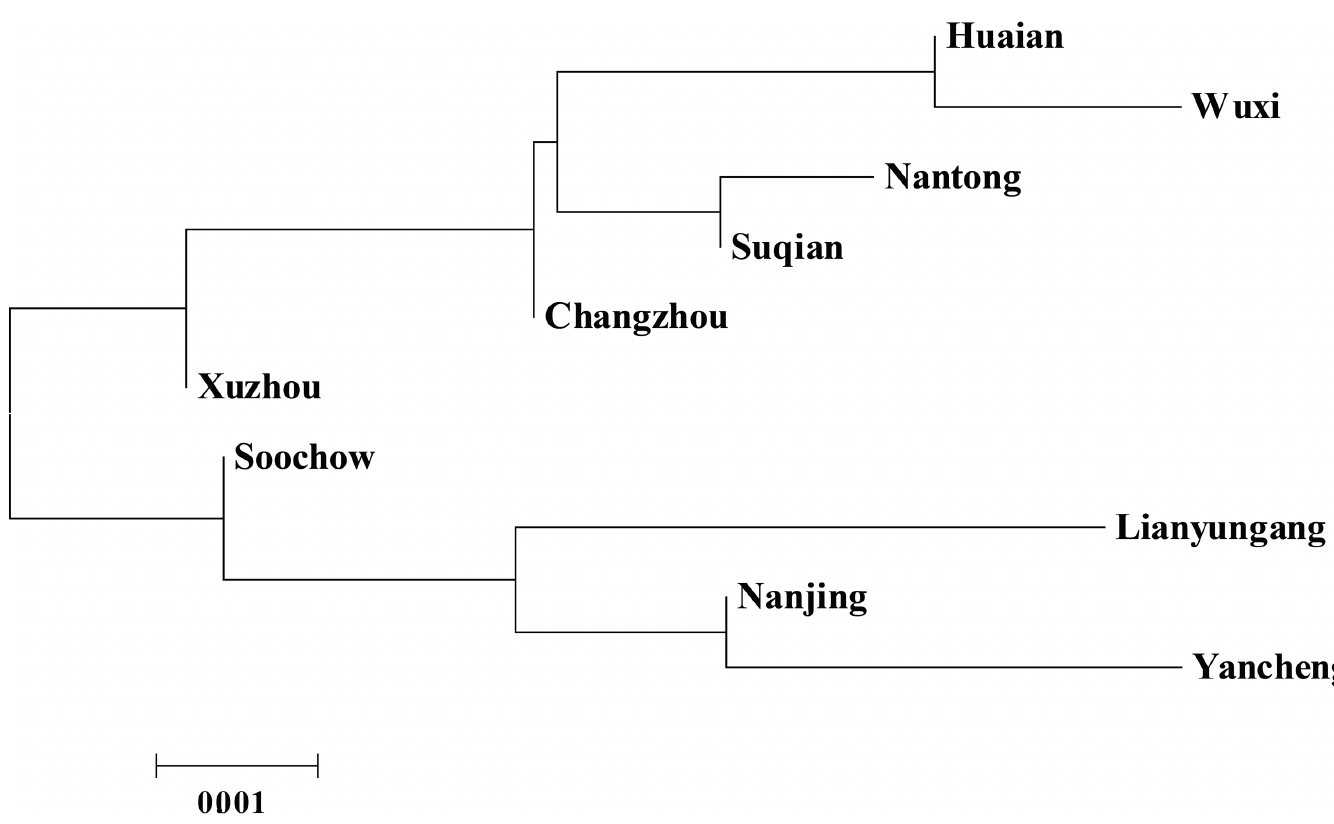
Fig 3. A Neighbor-Joining (N-J) tree composed of all 10 prefecture-level Han populations from Jiangsu province. The result of interior branchtest to assess the reliabilityof NJ reconstruction and the ruler were signed in the figure (the sum of branch length = 0.01566328).